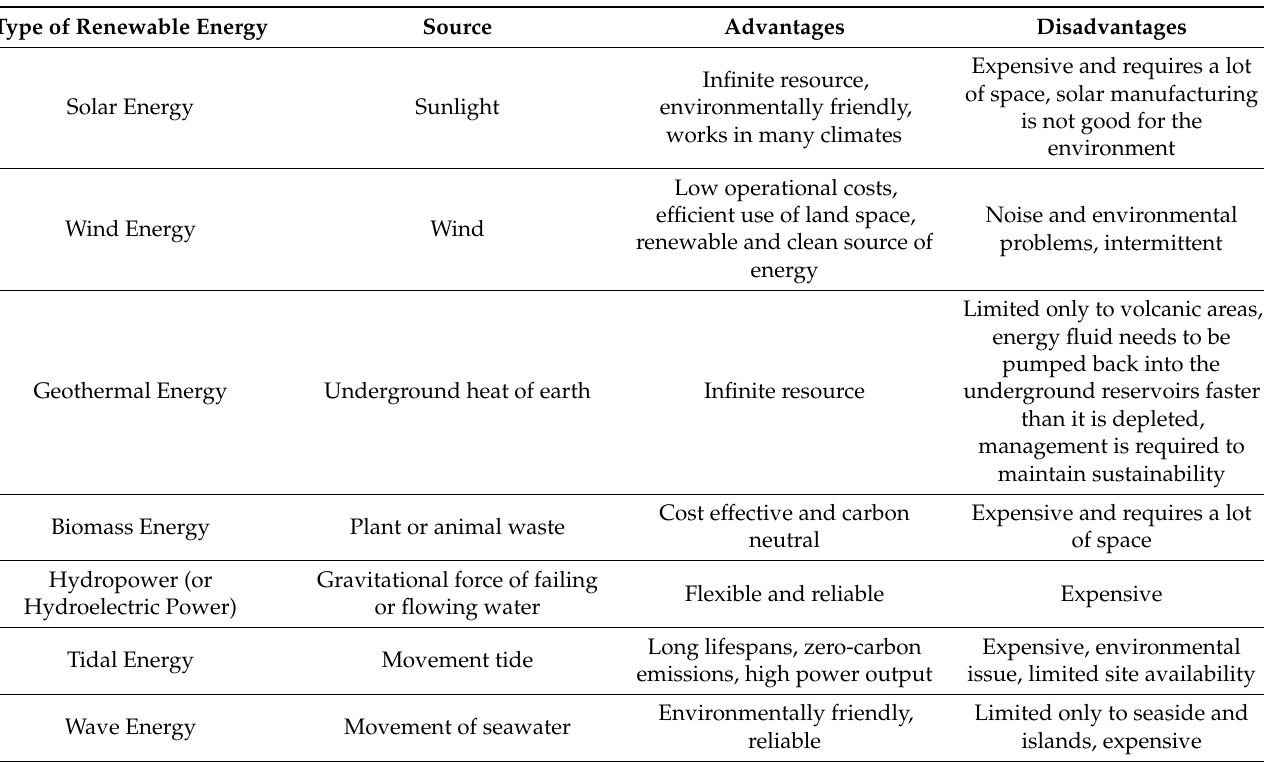
Table 1. Major types of renewable energy